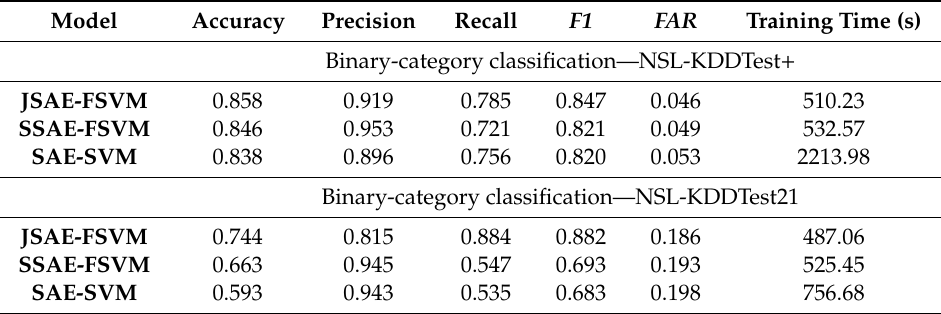
Table 4. Performance in binary classification tests for three hybrid models.